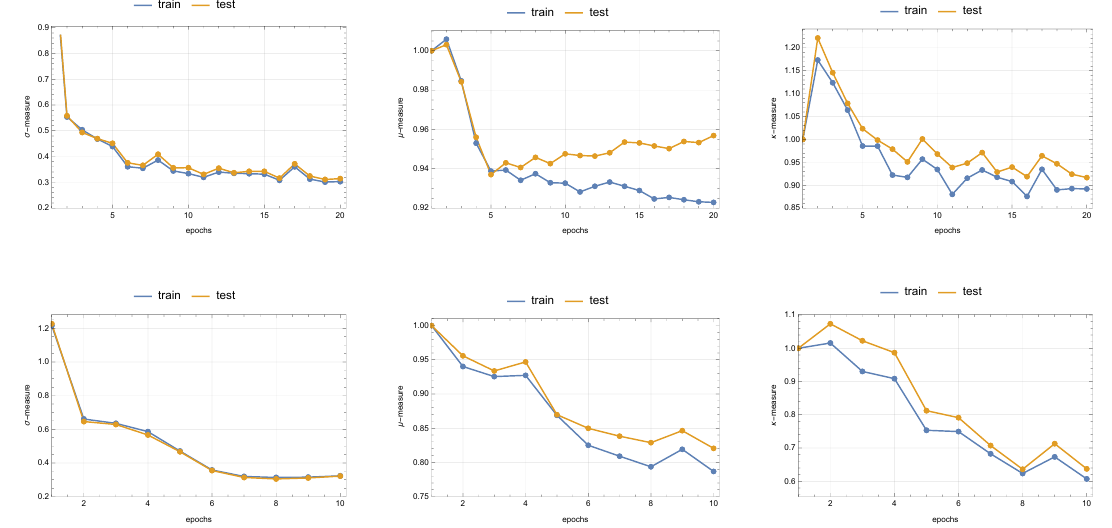
Figure 10 . Evolution of σ , κ , and µ -measures for a member of the Dwork family of quintics (2.7) with ψ = − 1 . For ease of visualization, the σ measure is reported in the original scale, whereas the 5 other measures are reported relative in the log scale following a normalisation. Following the case of the Fermat quintic, our architecture is a set of two three layer networks with 500 nodes in each layer and tanh activation (see figure 2). We use a train-test split of 90 : 10 . We use 10 , 000 points for training, a batch size of 500 , and a learning rate of 10 − 4 (top row) and 10 − 3 (bottom row). The loss function is a weighted combination of all three